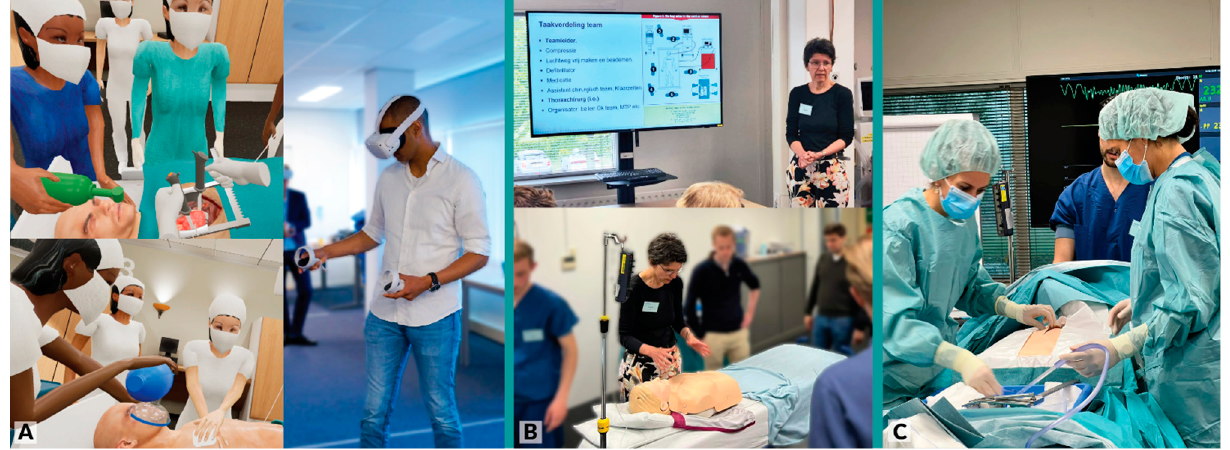
Figure 1. ( A ) Screenshots and pictures of the VR training; ( B ) pictures of the conventional training; ( C ) a participant performing the assessment case using the manikin.